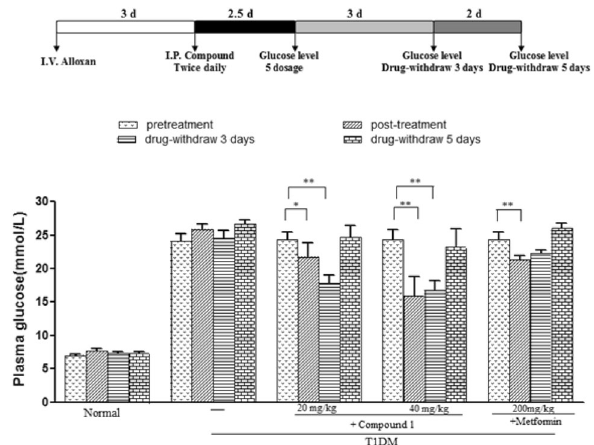
Fig. 3 Effect of compound 1 on alloxan-induced hyperglycemia mice. Experimental procedure was shown above. Data are shown as mean ± SEM (n = 10 in each group). * P \ 0.05, ** P \ 0.01 (Dunnett’s test). Metformin served as a positive control